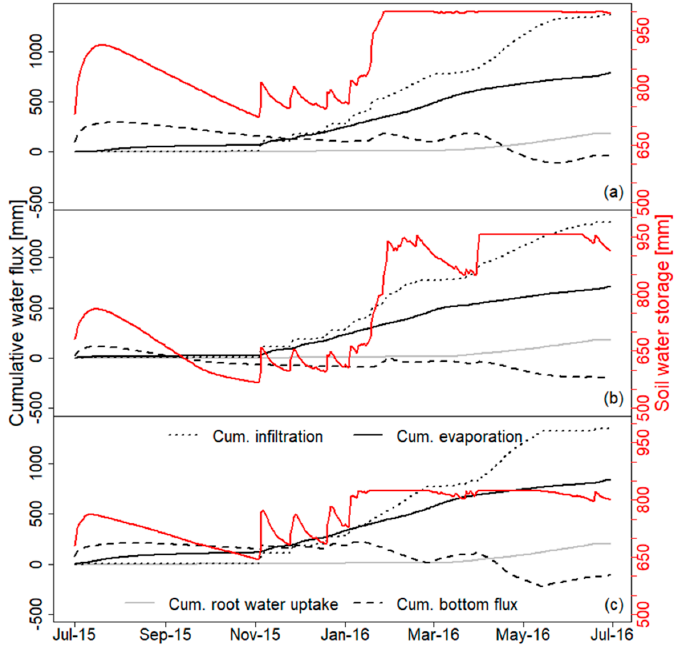
Figure 8. Cumulative (Cum.) water fluxes for one year. ( a ) Riparian zone; ( b ) middle zone; and ( c ) fringe zone. Table 11. Annual water balance from the Hydrus-1D method for each hydrological zone.